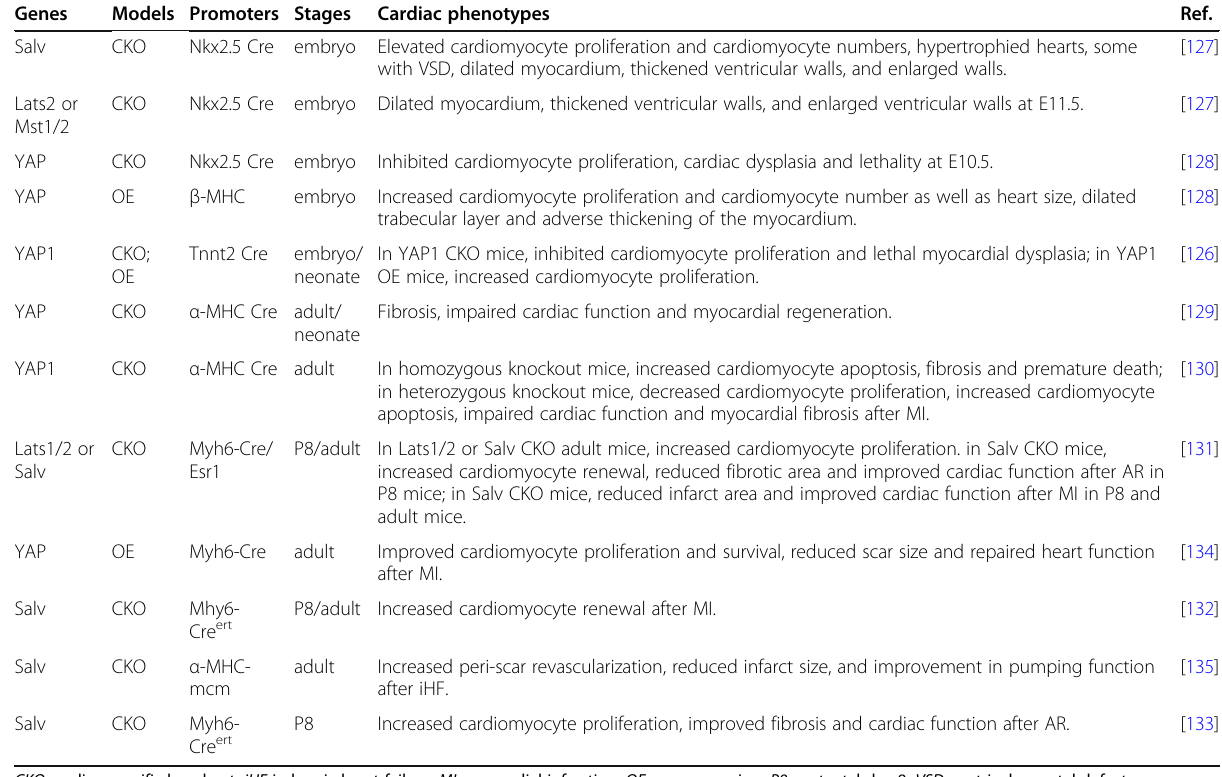
Table 1 Mouse cardiac phenotypes in the activated or inactivated state of Hippo signaling Genes Models Promoters Stages Cardiac